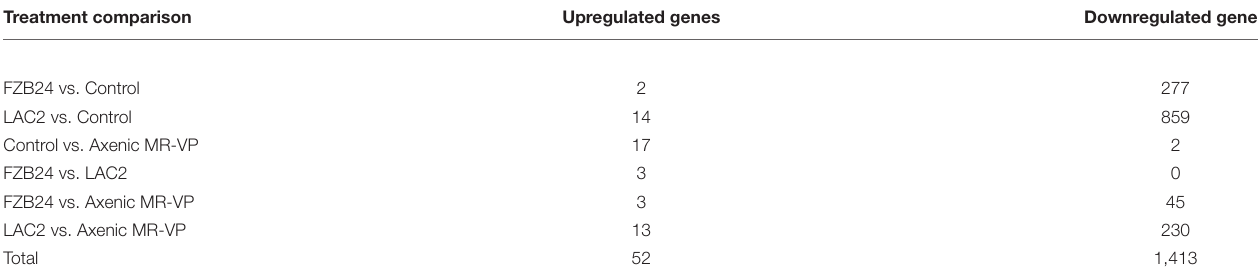
TABLE 3 | Numbers of upregulated and downregulated genes between BVC treatments from isolates cultured on MR-VP media according to MACE RNA-seq. Treatment comparison Upregulated genes Downregulated genes